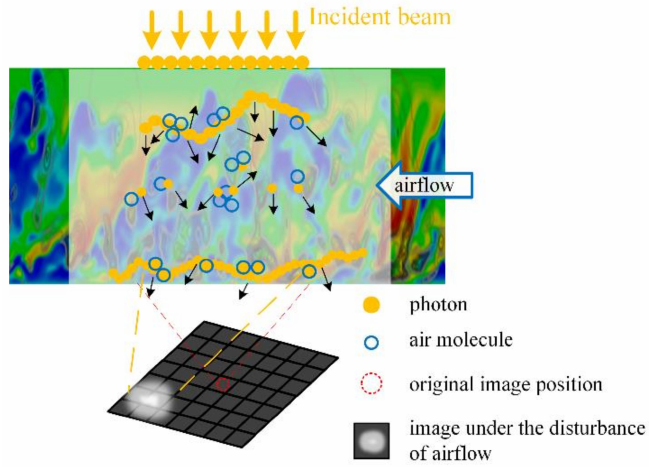
Figure 1. Disturbance in light transmission and the resulting distorted